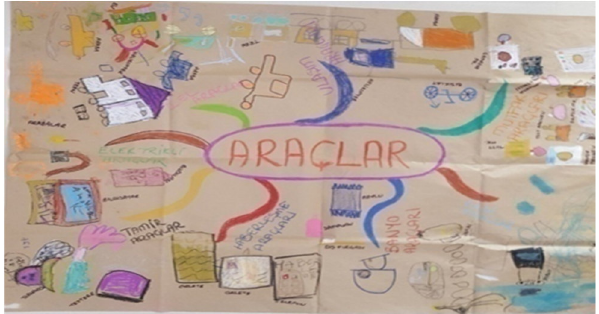
Figure 1. Example of a mind map made with a large